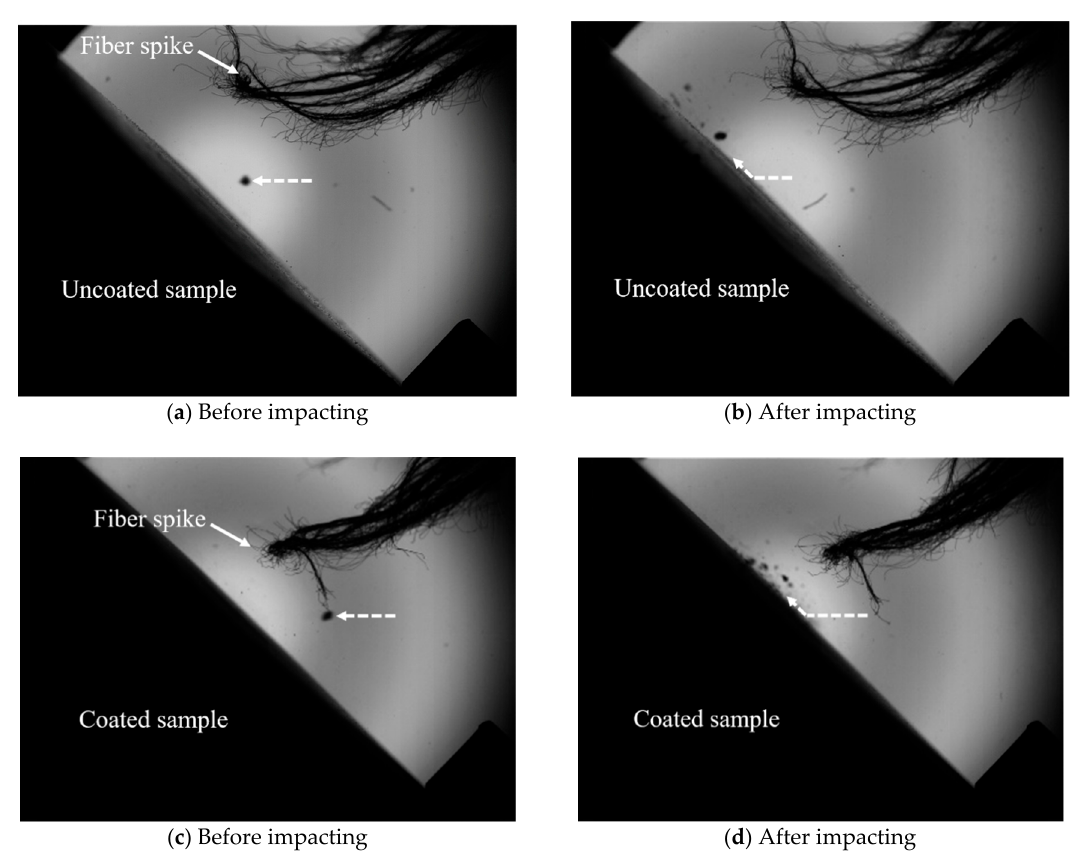
Figure 8. Impacting behavior of sand on an uncoated Ti alloy sample and on the sample coated with TiN/ZrN.